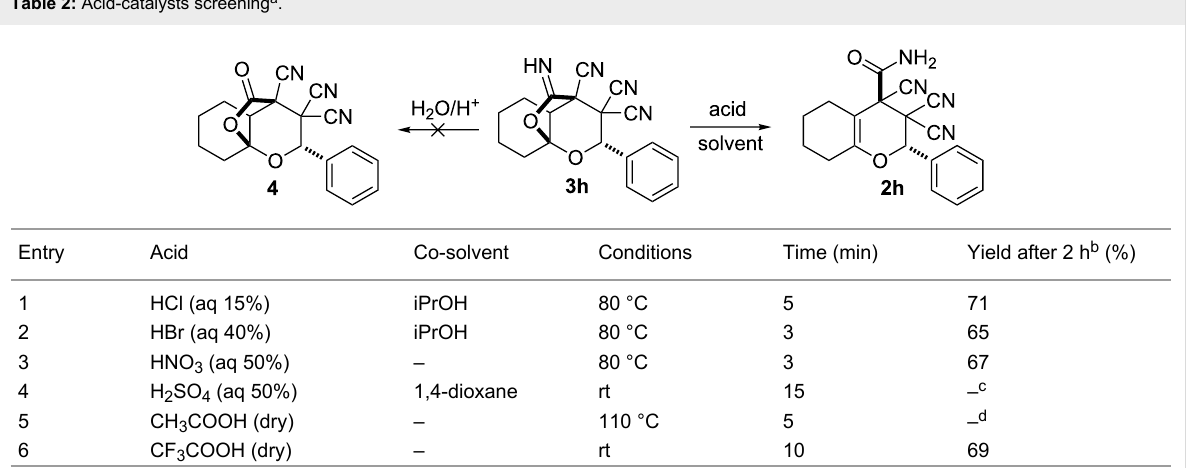
Table 2: Acid-catalysts screening a